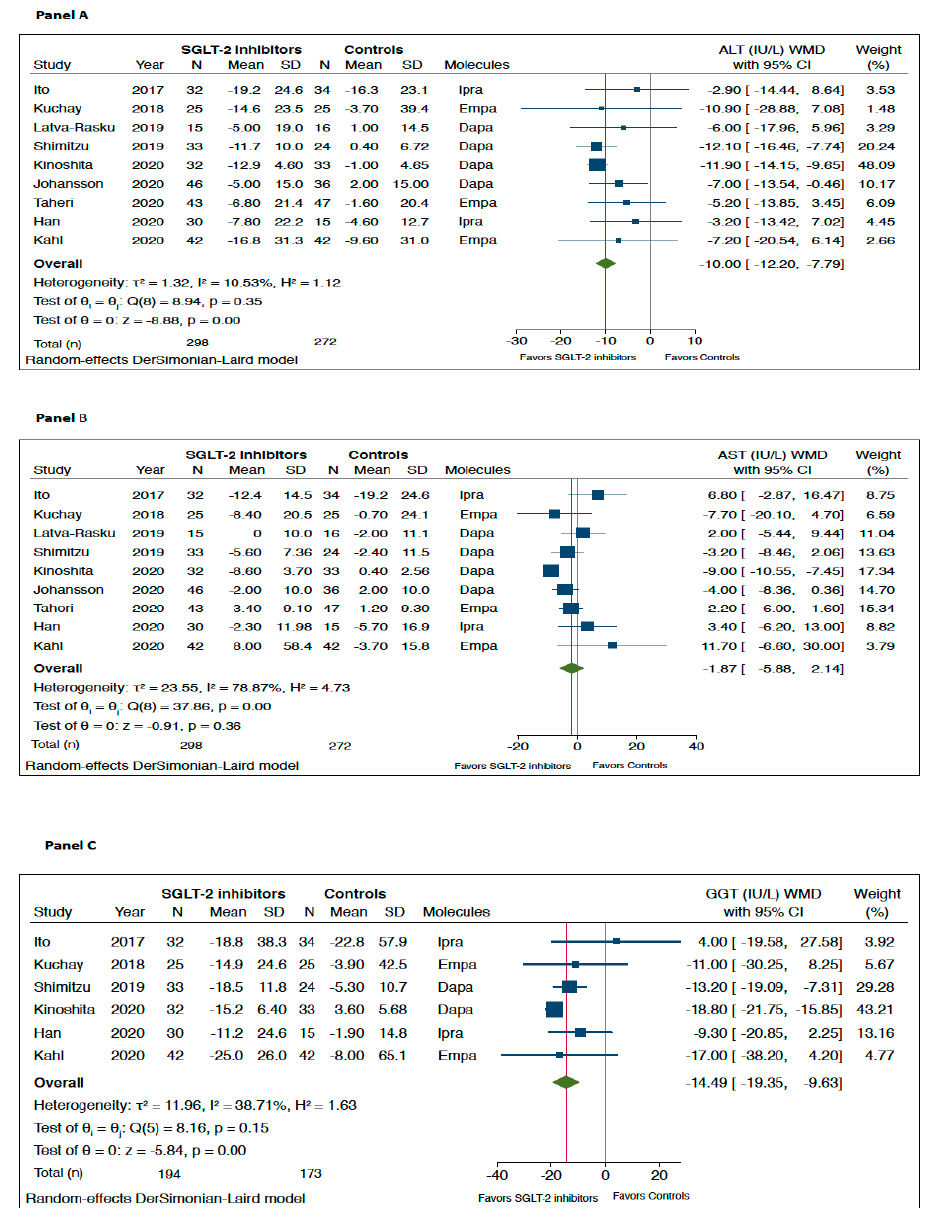
Figure 1. Forest plot of the effect of SGLT-2 inhibitors on serum liver enzyme levels (i.e., serum alanine aminotransferase (ALT) ( n = 9 randomized controlled trials (RCTs), panel A ), aspartate aminotransferase (AST) ( n = 9 RCTs, panel B ), and gamma-glutamyltransferase (GGT) ( n = 6 RCTs, panel C )) as compared with placebo or reference therapy. The pooled (green diamond) and individual effect sizes for RCTs included were expressed as weighted mean difference (WMD) and 95% confidence intervals (CI). Note: If not available, the SDs of the weighted mean difference were estimated using a specific formula (as reported in the Methods